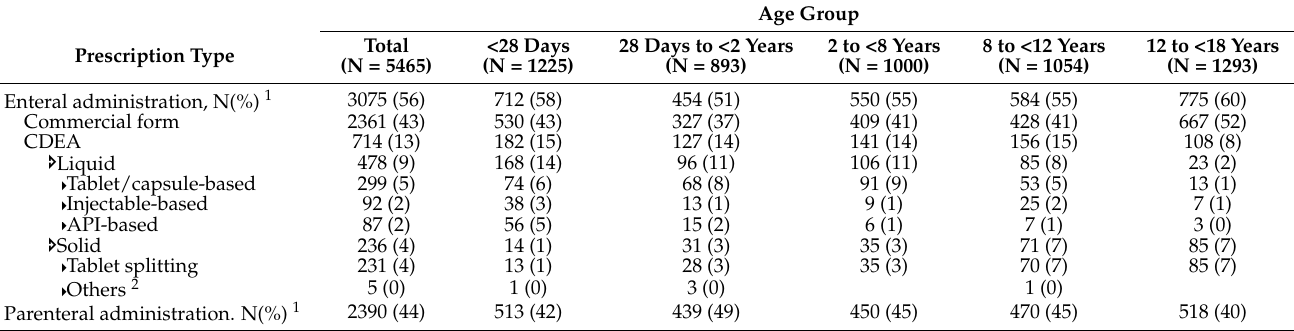
Table 3. Active prescriptions for the total population (N = 606).